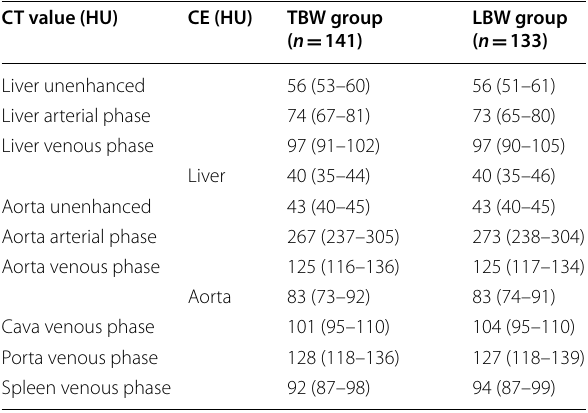
The median Live CE did not differ between groups at the Mann–Whitney U test ( p